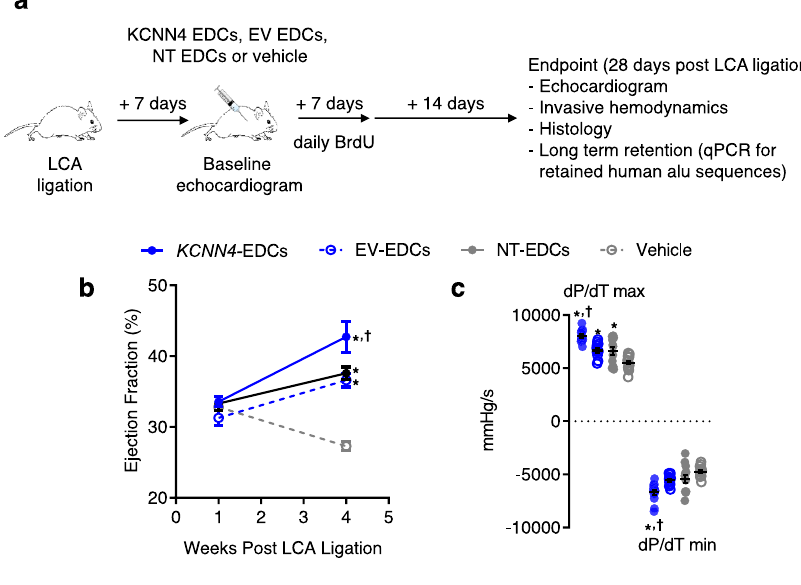
Fig. 5 Effects of KCNN 4 overexpression on myocardial function. a Schematic of in vivo experiments comparing the effect of KCNN4-engineered human EDCs ( KCNN4 -EDCs) to empty vector human EDCs (EV-EDCs), nontransduced human EDCs (NT-EDCs) and vehicle using a NOD/SCID IL2R γ model of ischemic injury. LCA, left coronary ligation. b Effects of KCNN4 -EDCs ( n = 12 biological replicates), EV-EDCs ( n = 12 biological replicates), NT-EDCs ( n = 13 biological replicates), or vehicle ( n = 14 biological replicates) injection on echocardiographic ejection fraction 4 weeks after LCA ligation. c Effects of KCNN4 -EDCs ( n = 12 biological replicates), EV-EDCs ( n = 12 biological replicates), NT-EDCs ( n = 13 biological replicates) or vehicle ( n = 14 biological replicates) injection on invasive hemodynamic measures of myocardial function 4 weeks after LCA ligation. All data are presented as individual and mean values ± SEM. Signi fi cance is indicated in all panels using * P < 0.0001 vs. vehicle-treated mice, † P < 0.05 vs . EV- and NT-EDCs treated mice. For precise P values, see Supplemental Source Data and Statistics fi le. All data was analyzed using a one-way ANOVA with individual-mean comparisons by Bonferroni multiple two-tailed comparisons test. Blue fi lled symbols = KCNN4 -transduced EDCs, blue open symbols = EV-EDCs, gray fi lled symbols = NT-EDCs, gray open symbols = Vehicle. EDC explant-derived cell, EV empty